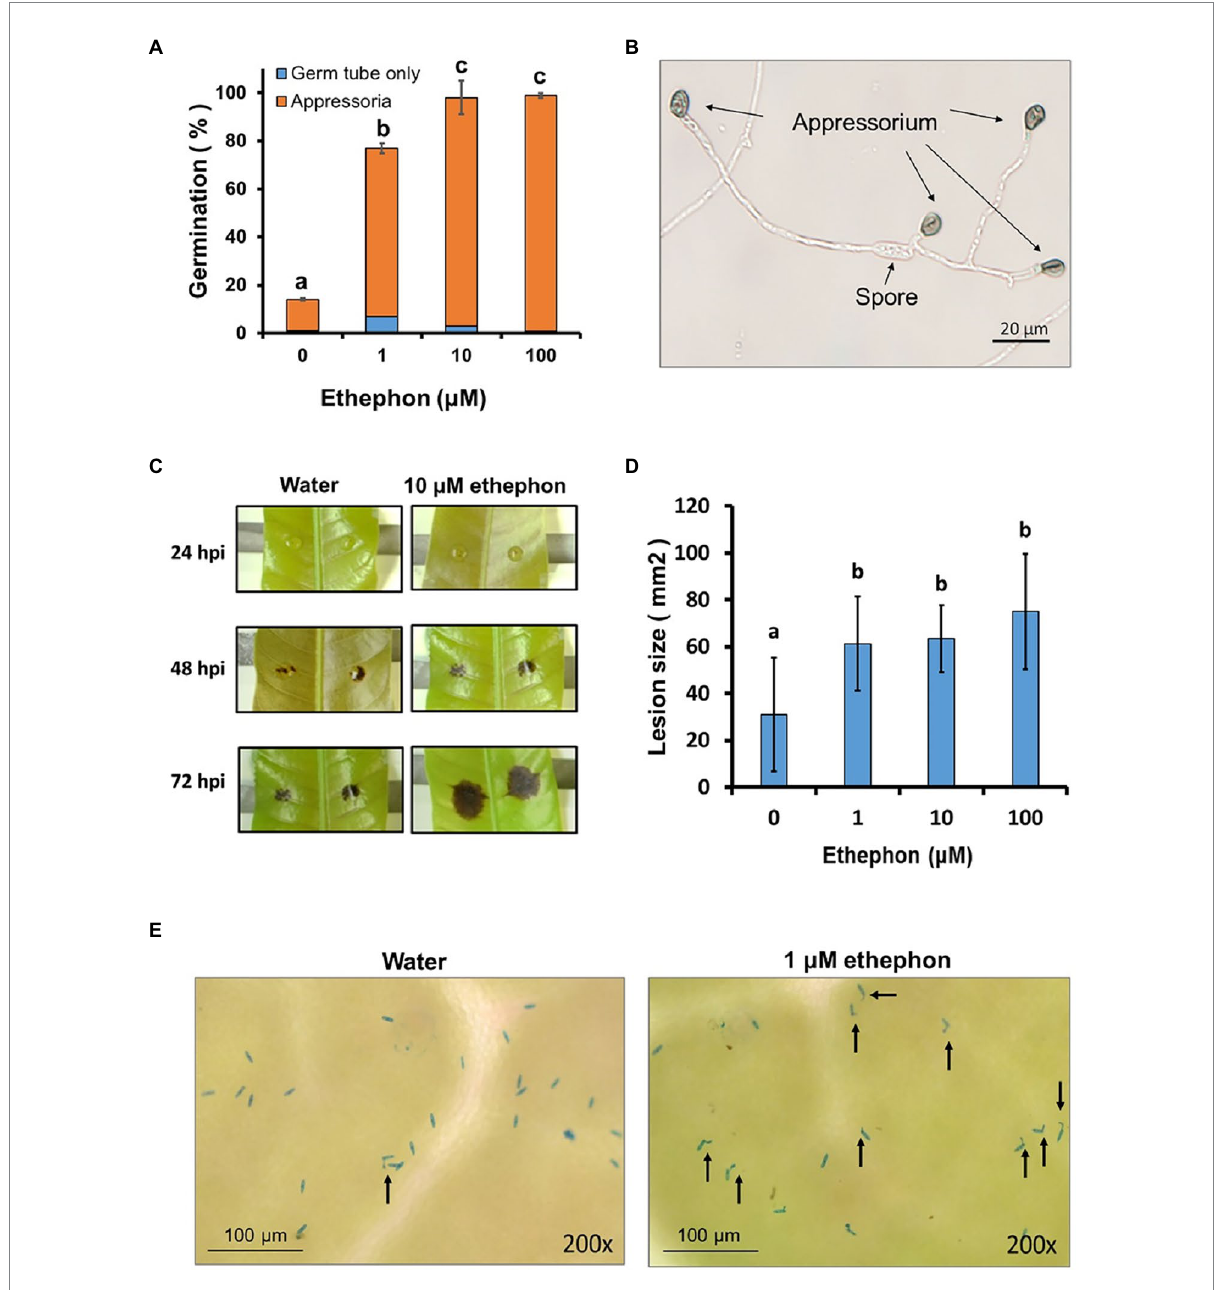
FIGURE 1 The effect of ethephon treatments on spore germination, appressorium formation (A,B) and virulence (C–E) of Colletotrichum asianum TYC-2. (A) Spore germination and appressorium formation of TYC-2 on glass slides at 24 h under 0–100 μ M ethephon treatments. (B) Multiple appressorium formation under 100 μ M ethephon treatment. (C) Lesion sizes caused by TYC-2 on young mango leaves under water and 10 μ M ethephon treatment at 24–72 h postinoculation (hpi). (D) Lesion size at 72 hpi was measured with ImageJ. (E) Spore germination and appressorium formation on the leaf surface at 2 hpi. The data were analyzed by one-way ANOVA, and different letters indicate significant differences between treatments ( p value <0.05) on germination (A) and lesion size (B)